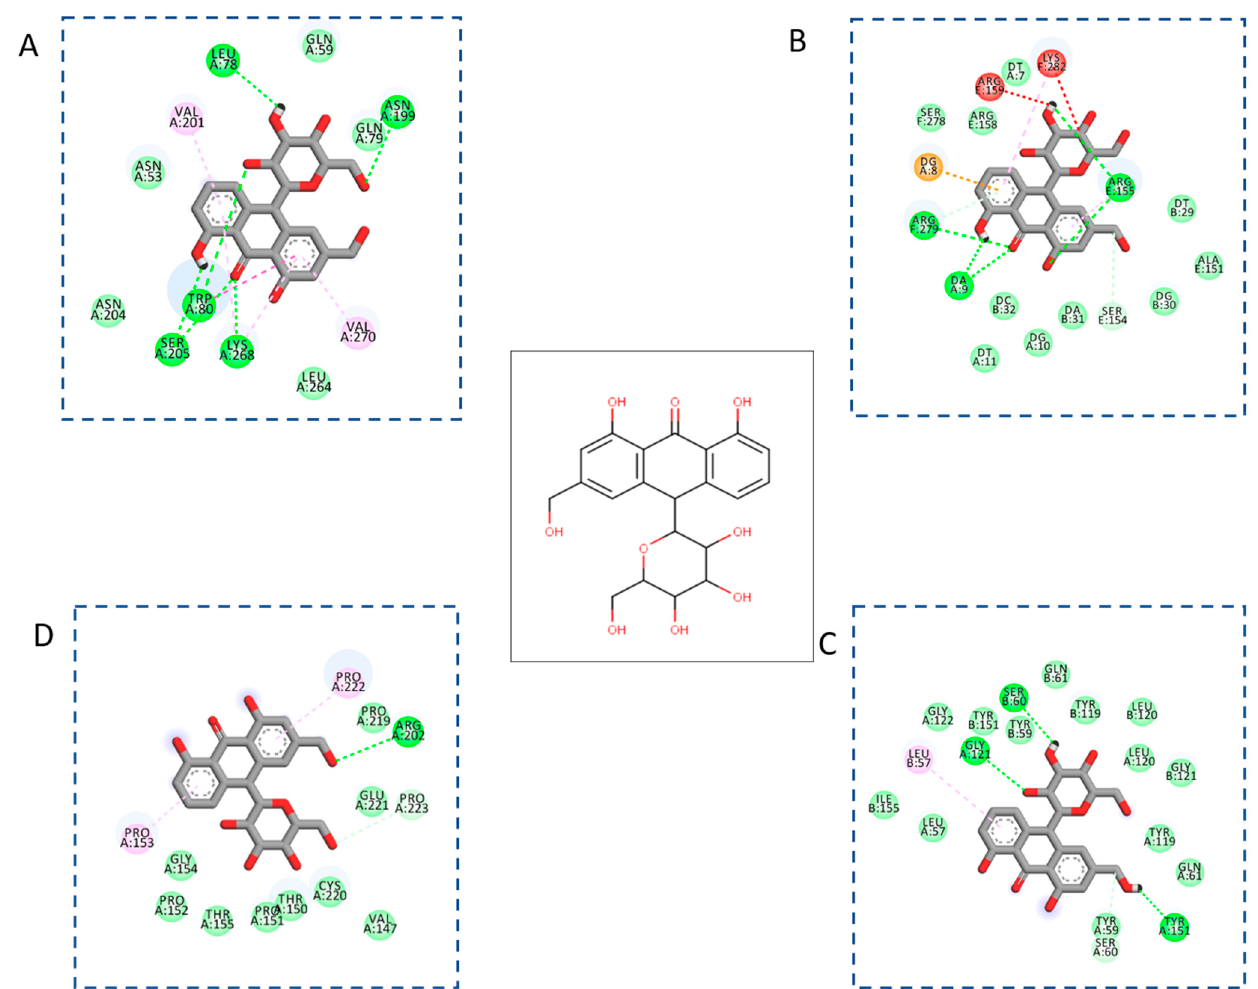
Figure 7. Interactions between aloin and the core targets. ( A ) AKT1, ( B ) c-Jun, ( C ) TNF α , and ( D ) p53.